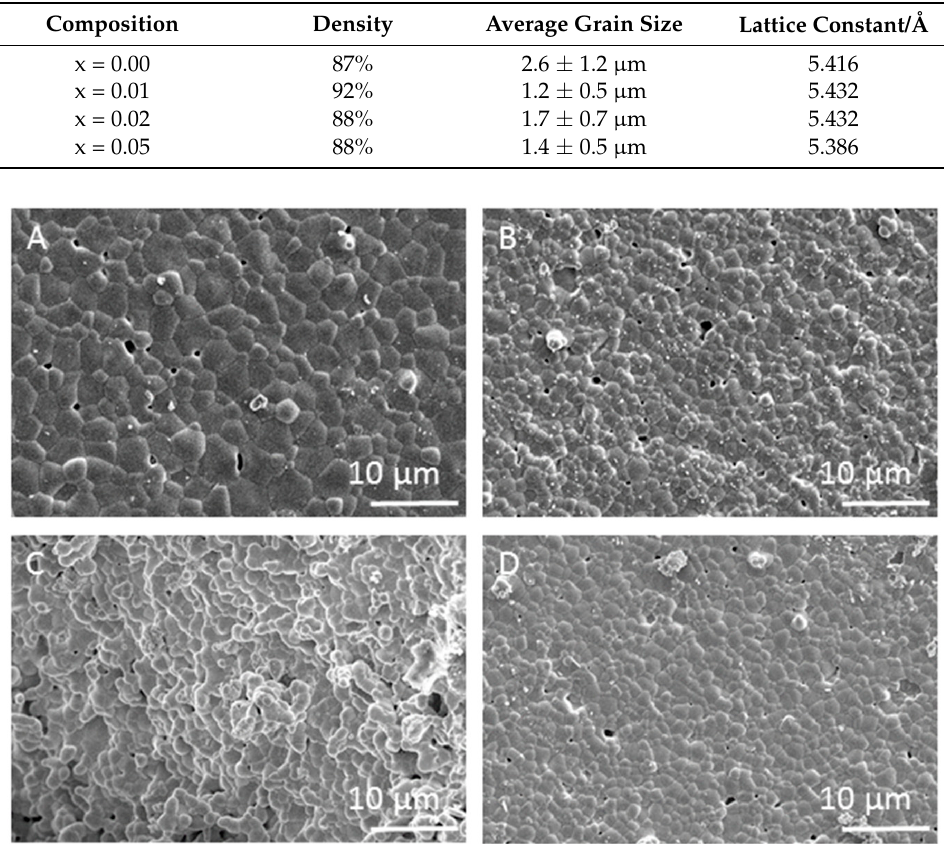
Figure 3. SEM images of the four different samples. ( A ) x = 0.00, ( B ) x = 0.01, ( C ) x = 0.02, and ( D ) x = 0.05.